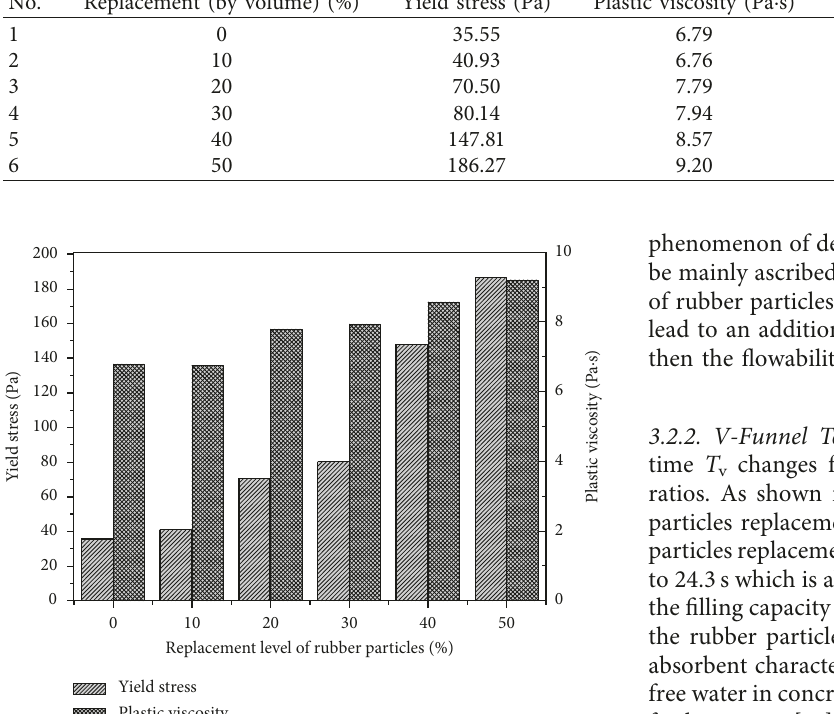
Figure 11: Rheological parameter of mortar pastes at different replacement levels of rubber particles.